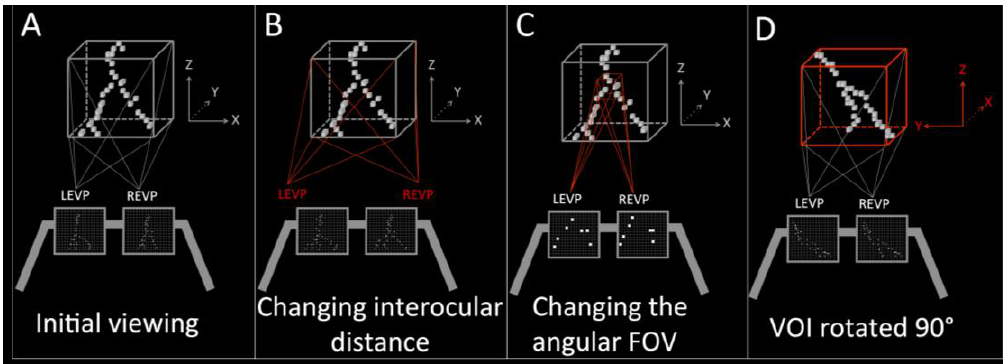
Figure 5. This is an illustration of VR used with D3D. This is an image of a simulated dataset of breast microcalcifications illustrating the head mounted display (HMD) as the gray goggles with the left eye viewing perspective (LEVP) and the right eye viewing perspective (REVP) [15]. Note that the D3D system can view the microcalcifications as follows: ( A ) initial viewing perspective; ( B ) widened interocular distance to enhance binocular disparity; ( C ) altered the angular field of view (FOV); and ( D ) rotated the volume of interest (VOI). Reprinted from Journal of Medical Devices: Evidence and Research , Volume 9, Douglas et al. “D3D augmented reality imaging system: proof of concept in